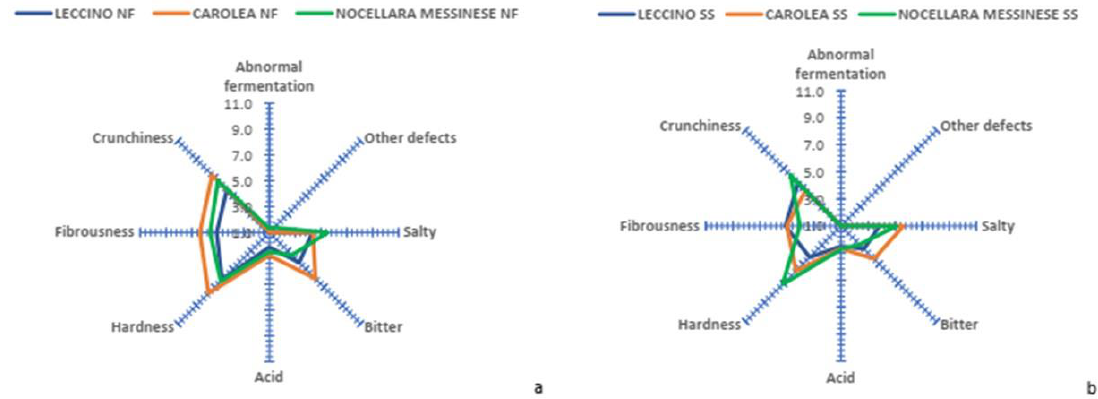
Figure 2. Sensory profile of olives processed with natural fermentation ( a ) and in the Spanish style ( b ).